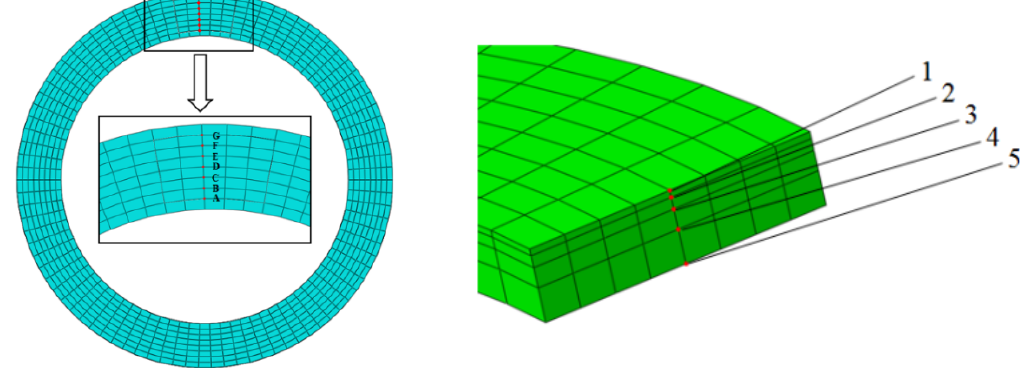
Figure 6. Distributions of nodes along di ff erent paths of brake disc.